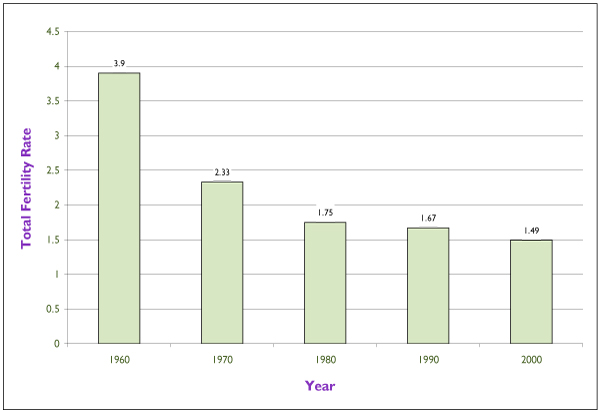
Total Fertility Rate for Canada 1960–2000 Source: Statistics Canada, Vital Statistics, 1960–2000